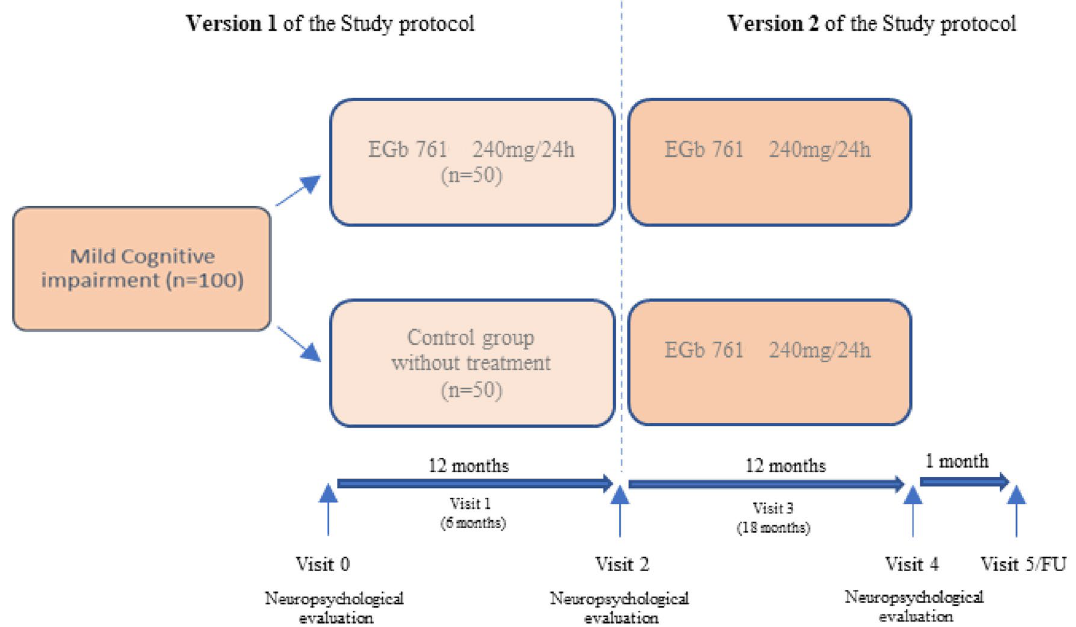
Figure 1. ACE-2020-EGb761 Study Flow Chart. The ACE-2020-EGb761 study was initially designed as a Phase IV, single-center, randomized, open-label, parallel-group clinical trial consisting of the 12-month follow-up of a cohort of participants with MCI (version 1). In January 2022, an extension with an additional 12-month follow-up period was